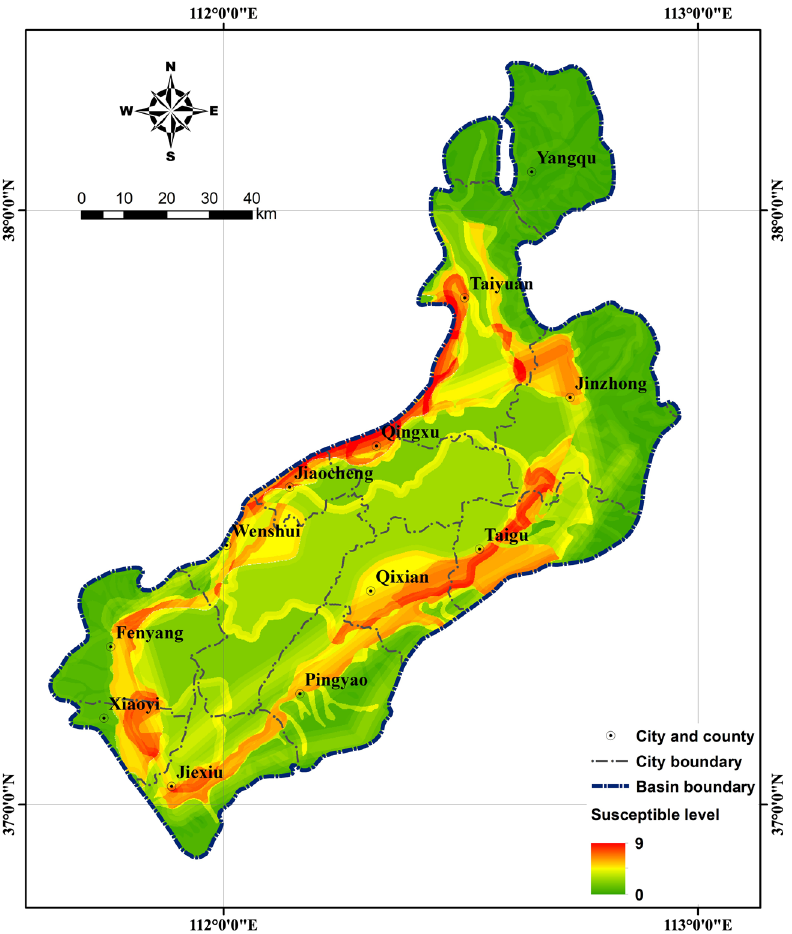
Figure 5. Map showing earth fissure susceptibility in the study area.